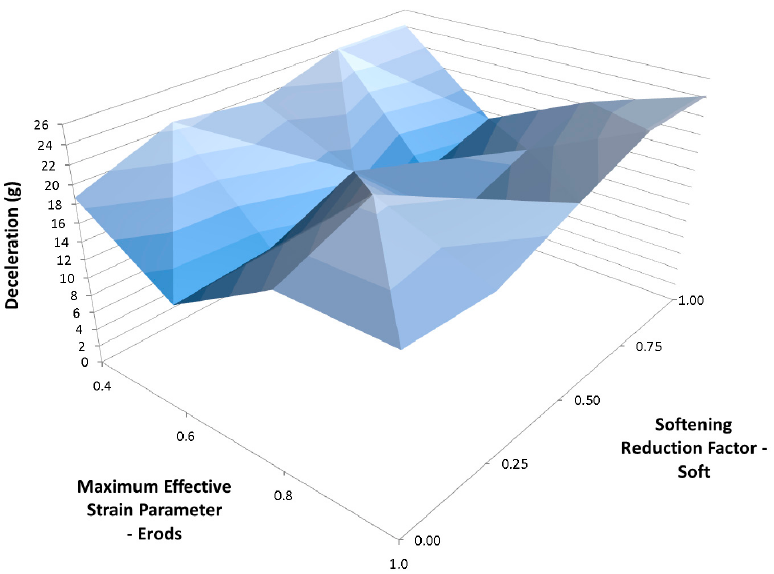
Figure 17. Effect of Erods parameter and Soft factor with Slim T = 0.0, Slim C = 1.0, Slim S = 1.0, TSize = 1 × 10 − 11 and FS = − 1.0.